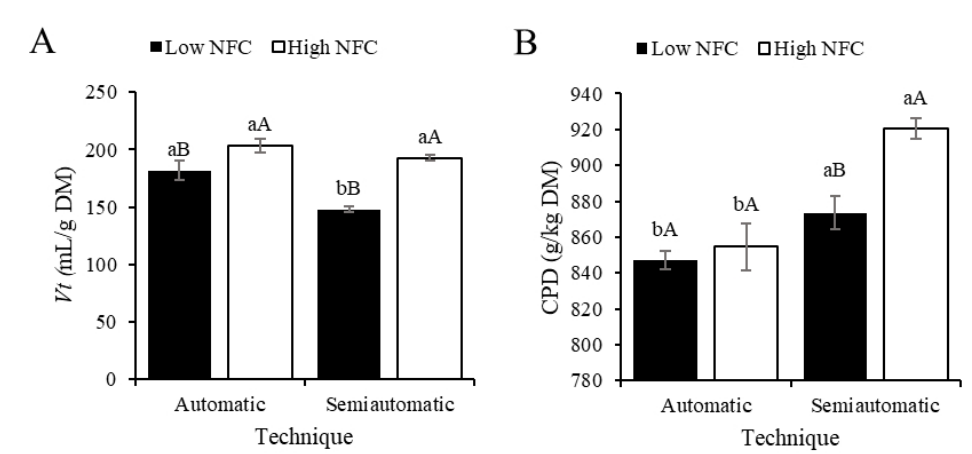
Figure 1. Interaction of “diet × time” for the potential gas production from total carbohydrates ( Vt ) ( p = 0.034) ( A ) and crude protein degradability (CPD) ( p = 0.0026) ( B ). Lowercase letters compare the means between techniques with low NFC and high NFC and capital letters compare the means within the automatic and semiautomatic systems.